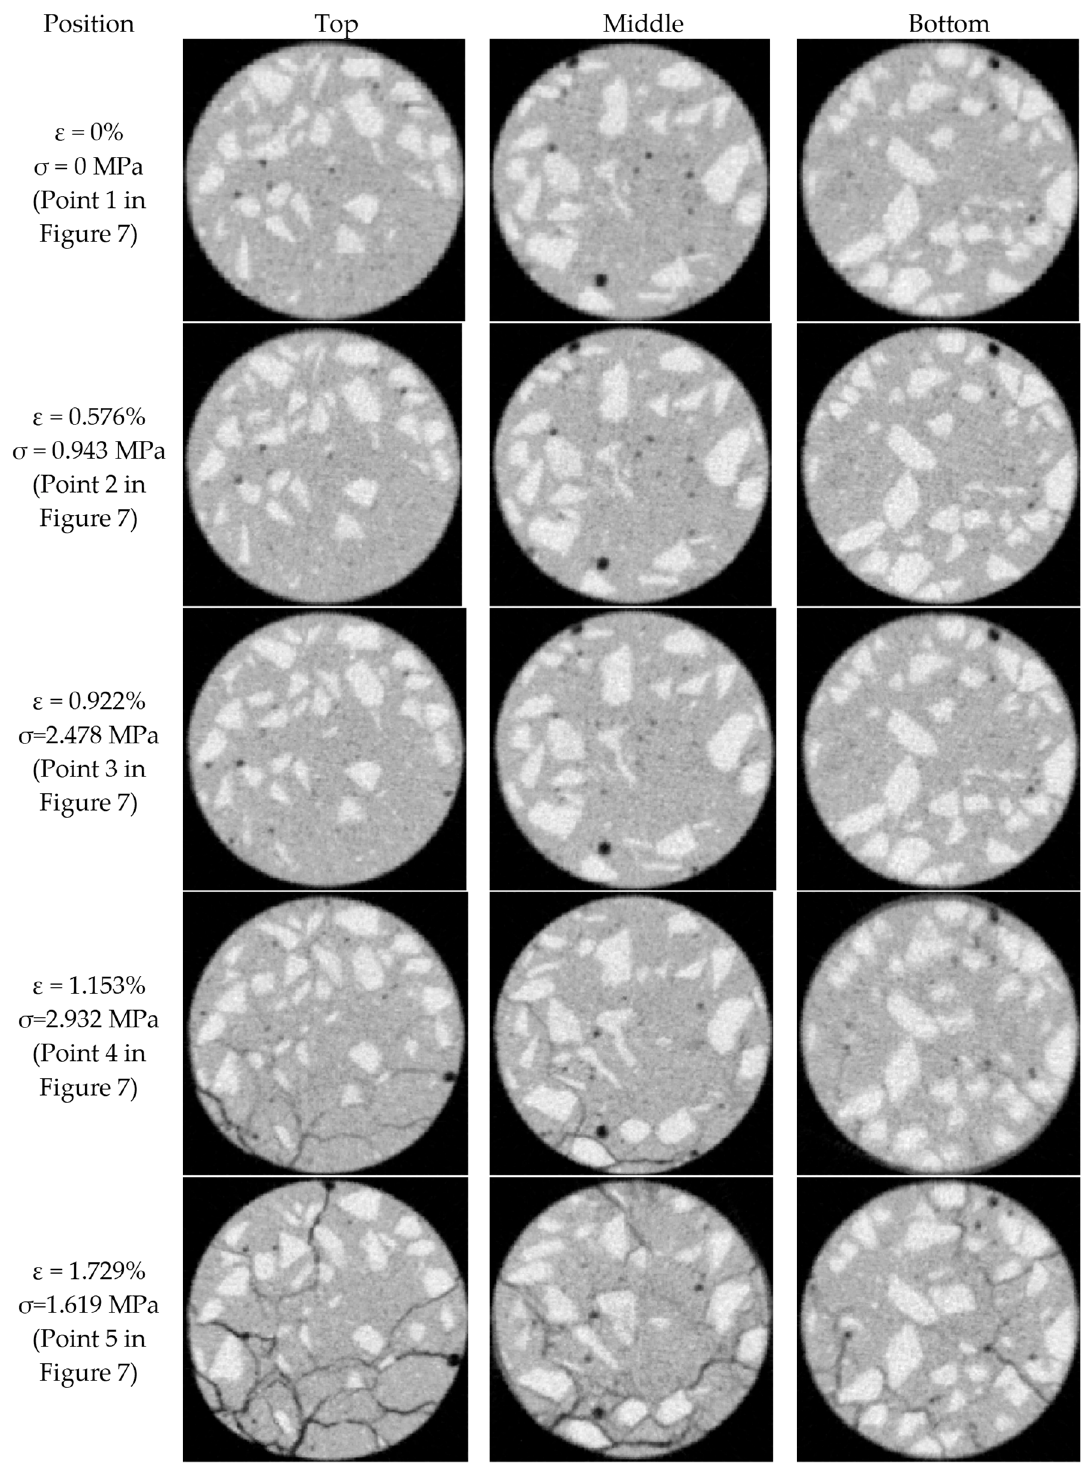
Figure 9. The reconstructed CT images of the CWRB sample at the top, middle, and bottom positions, under five loading stages in the stress strain curve.